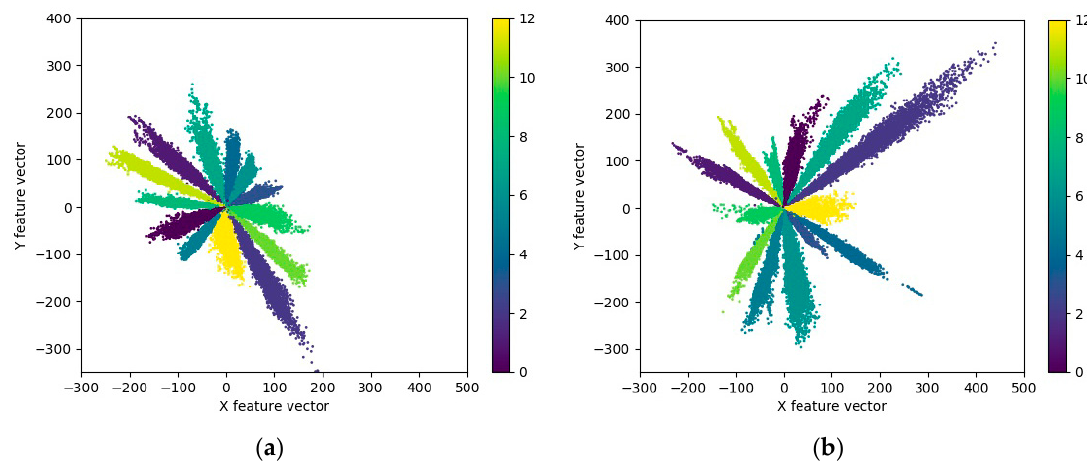
Figure 9. Visualization of the feature extracted by model A with a variety of loss functions at the SNR of 15 dB. ( a ) With the loss function L S ; ( b ) With the loss function L AMS and µ = 0.5. Each data point represents the two-dimensional feature extracted from HRRP data by the model A, and di ff erent colors represent di ff erent target types. The total number of types is 13.